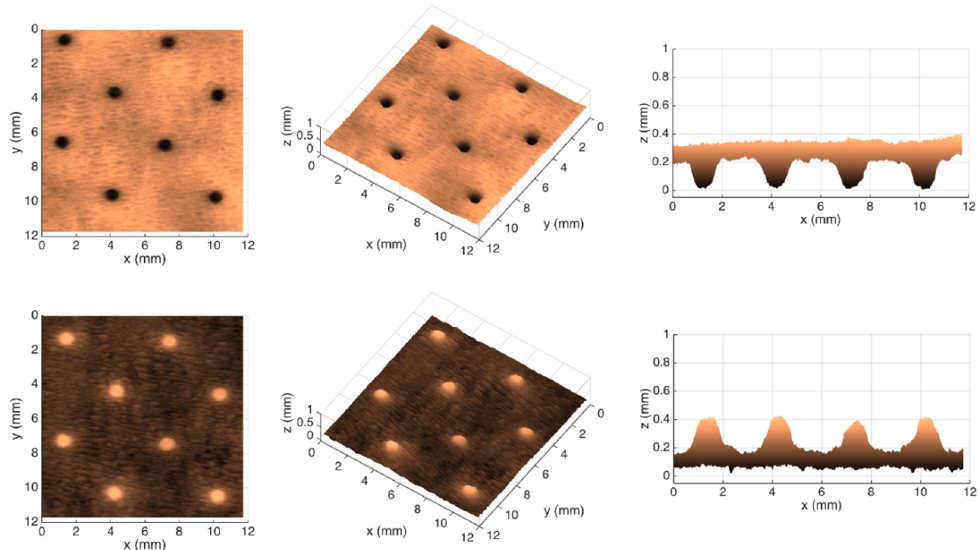
Figure 10. Different views of the 3D maps created for the front and back sides of the tissue-paper sample Bm rd .